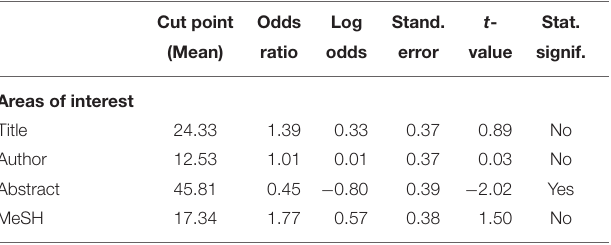
TABLE 4 | Summary of the relationship between number of MeSH queries issued and gaze (N number of MeSH queries issued = 256, N eye gaze = 256; statistical significance at